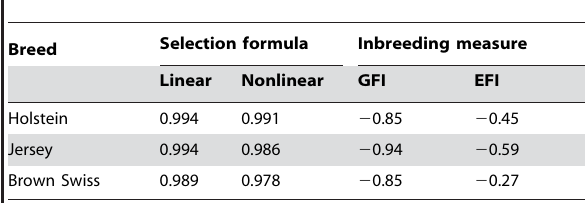
Table 3. The correlation between official and FMA (favorable minor allele) evaluation using linear and nonlinear formulas, as well as Correlation of the difference between FMA using linear weighting and official evaluation with GFI (genomic future inbreeding) and EFI (expected future